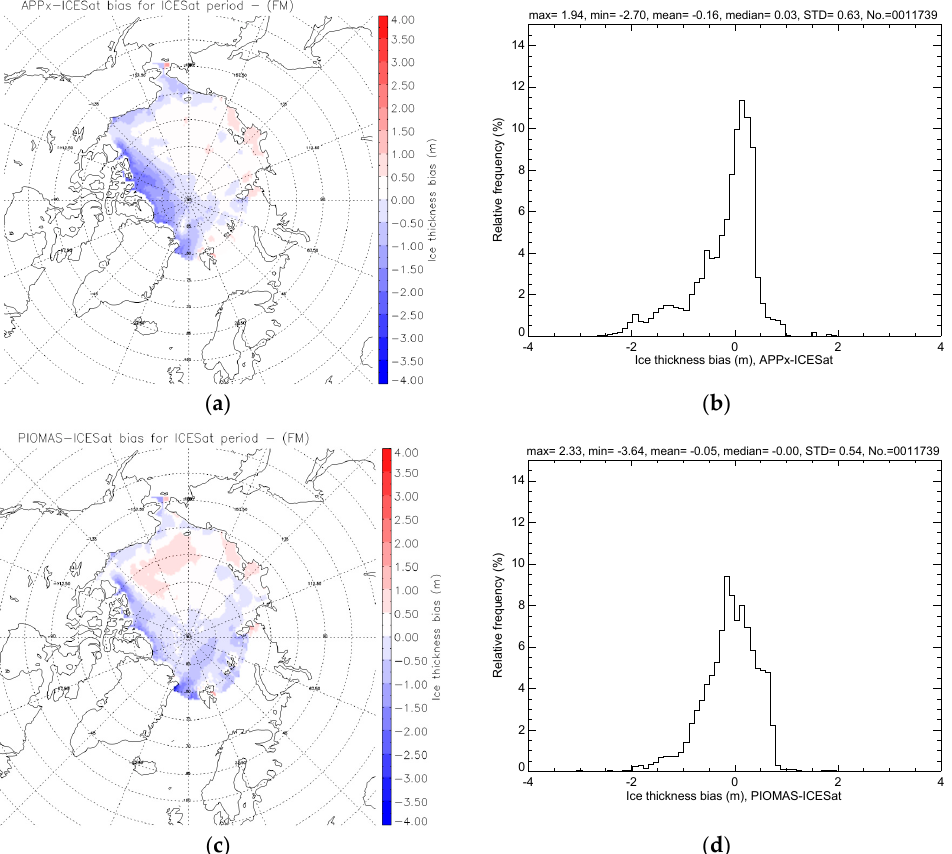
Figure 3. ( a – d ) Comparison of sea ice thickness from APP-x and PIOMAS relative to ICESat sea ice thickness for the winter period (FM) over 2003–2008. The bias images for APP-x in ( a ) and PIOMAS in ( c ) are shown on the left; the bias histograms for APP-x in ( b ) and PIOMAS in ( d ) are shown on the right.